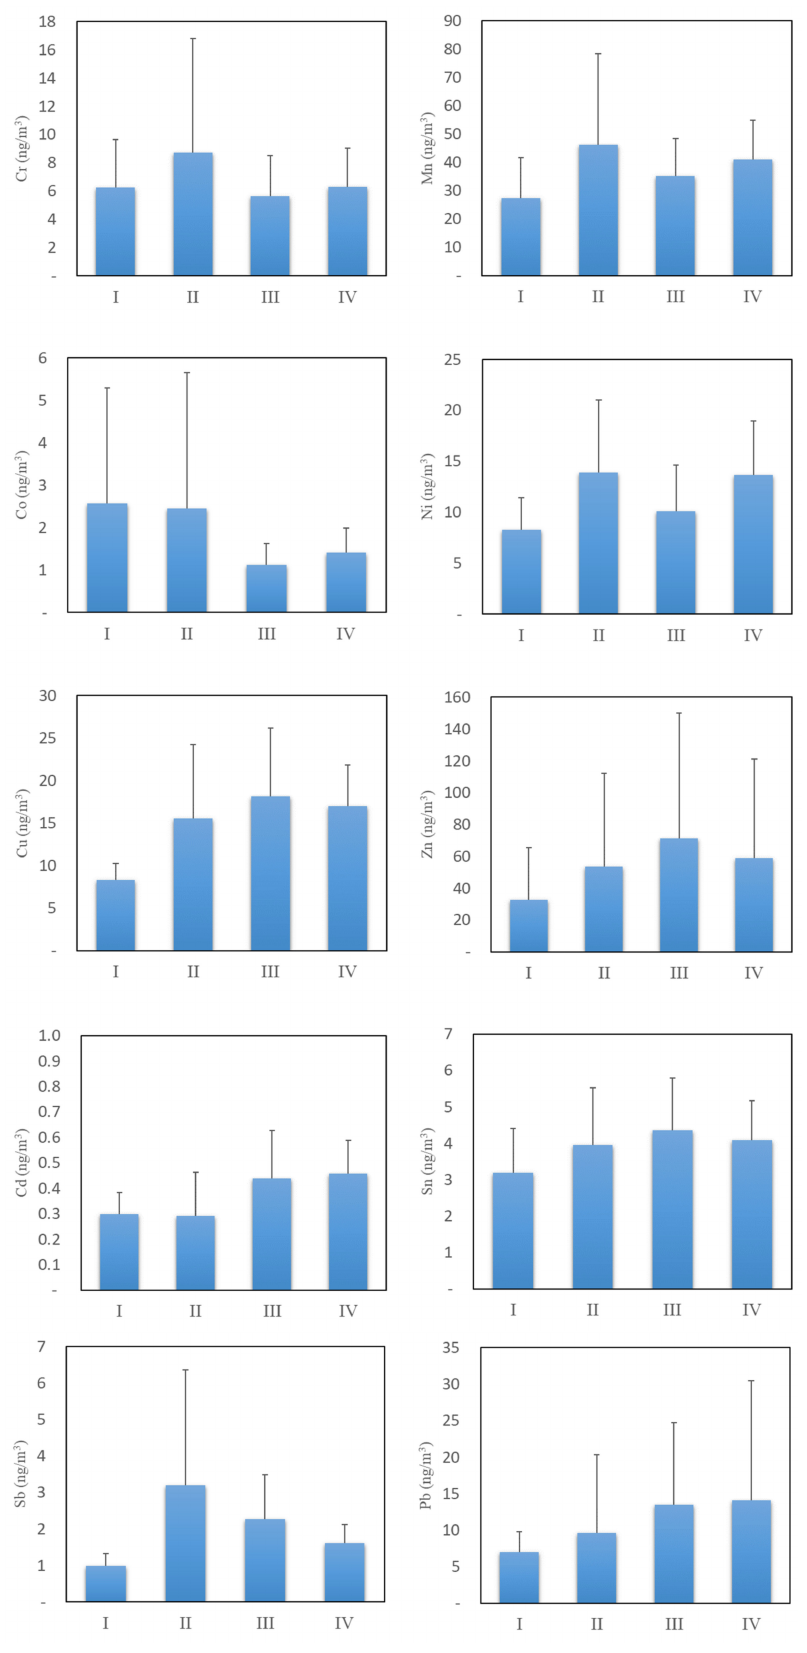
Figure 3. Size-resolved concentration of heavy metal elements in particulate